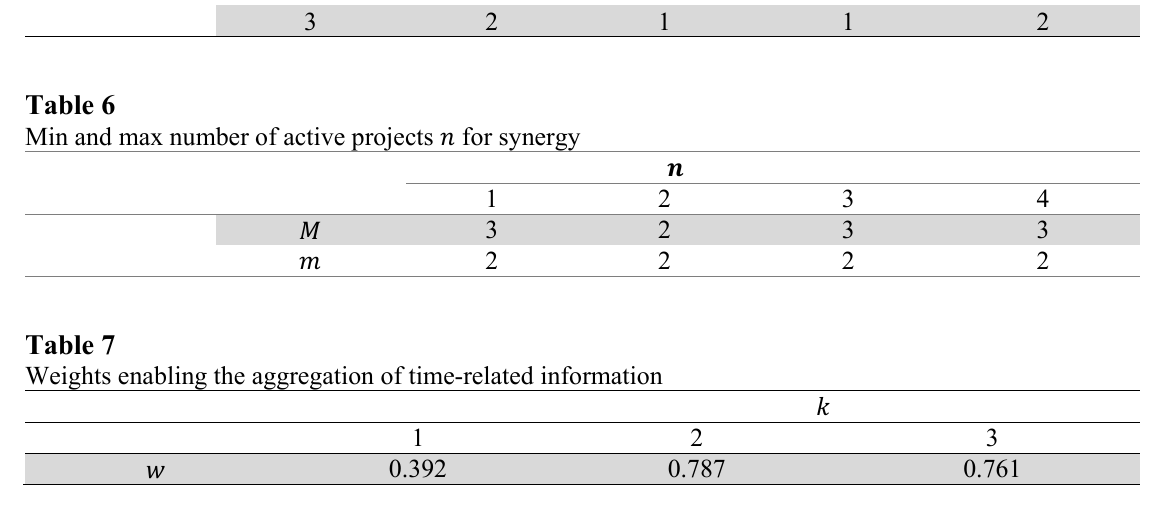
Synergy coefficient to (cid:1866) project set in period (cid:1863) (cid:1853) (cid:3041)(cid:3038)